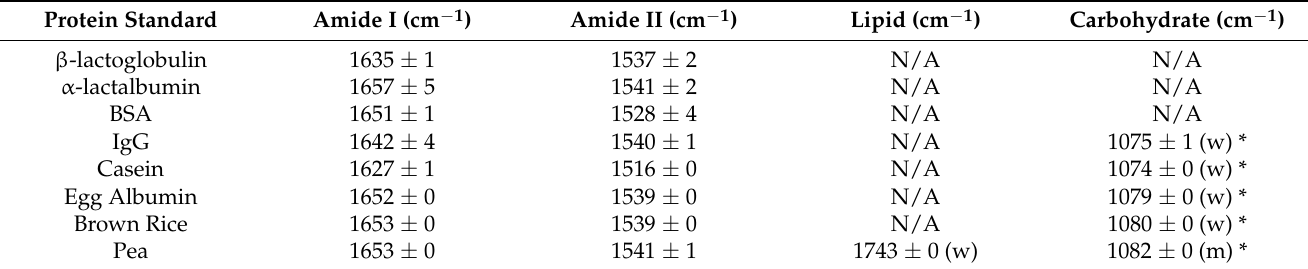
Table 1. MIR data for proteins in the amide I/II, lipid, and carbohydrate spectral regions. Protein